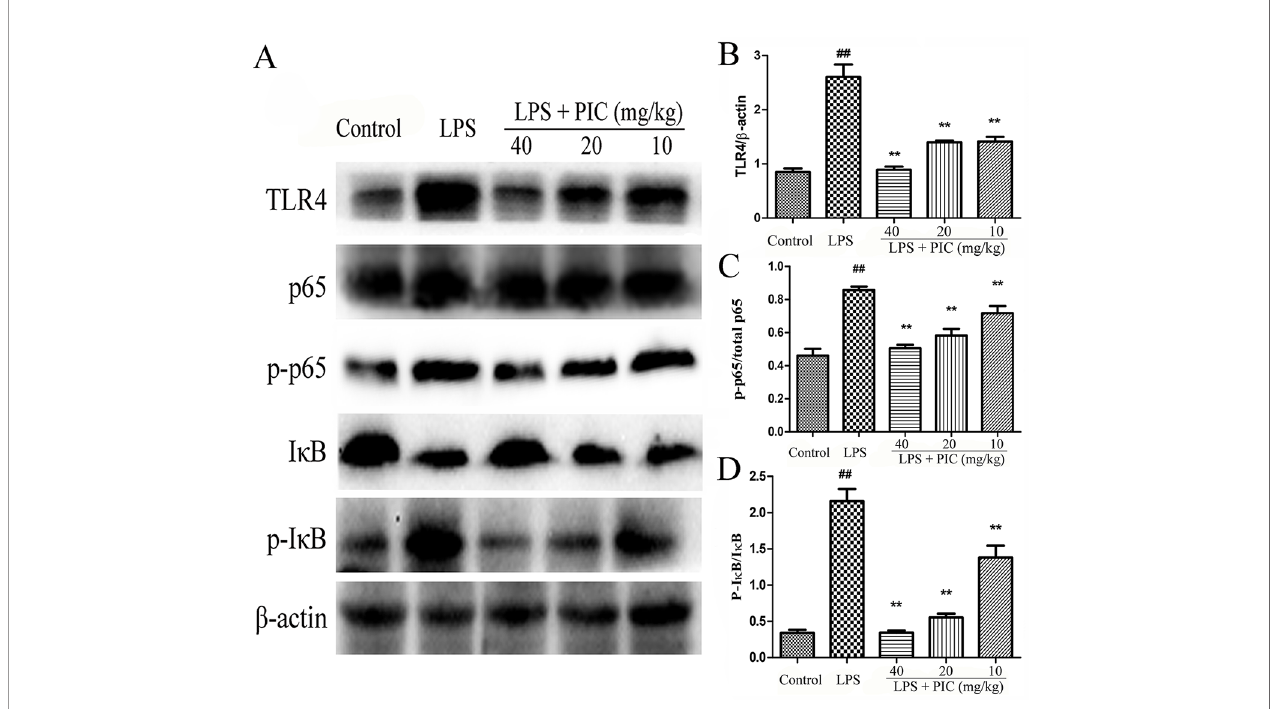
FIGURE 10 | The activation of TLR4/NF- k B pathway in lung tissues. (A) TLR4/NF- k B protein samples were analyzed by western blot with TLR4, I k B, p-I k B, p65, p-p65 antibodies. b -actin was used as a control. (B) Quanti fi cation of TLR4 proteins, (C) p-p65 proteins, and (D) p-I k B proteins was determined by densitometry. ## p < 0.01 is signi fi cantly different from the control group; ** p < 0.01 are signi fi cantly different from the lipopolysaccharide (LPS)